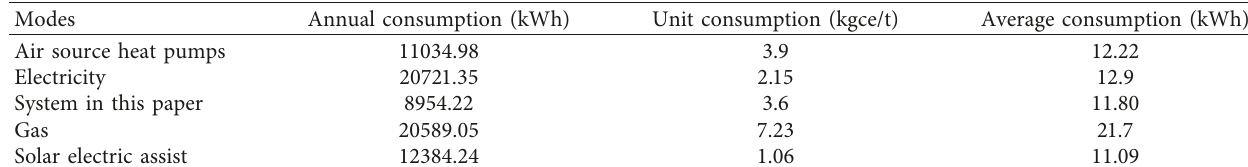
Table 2: Energy consumption under different preparation